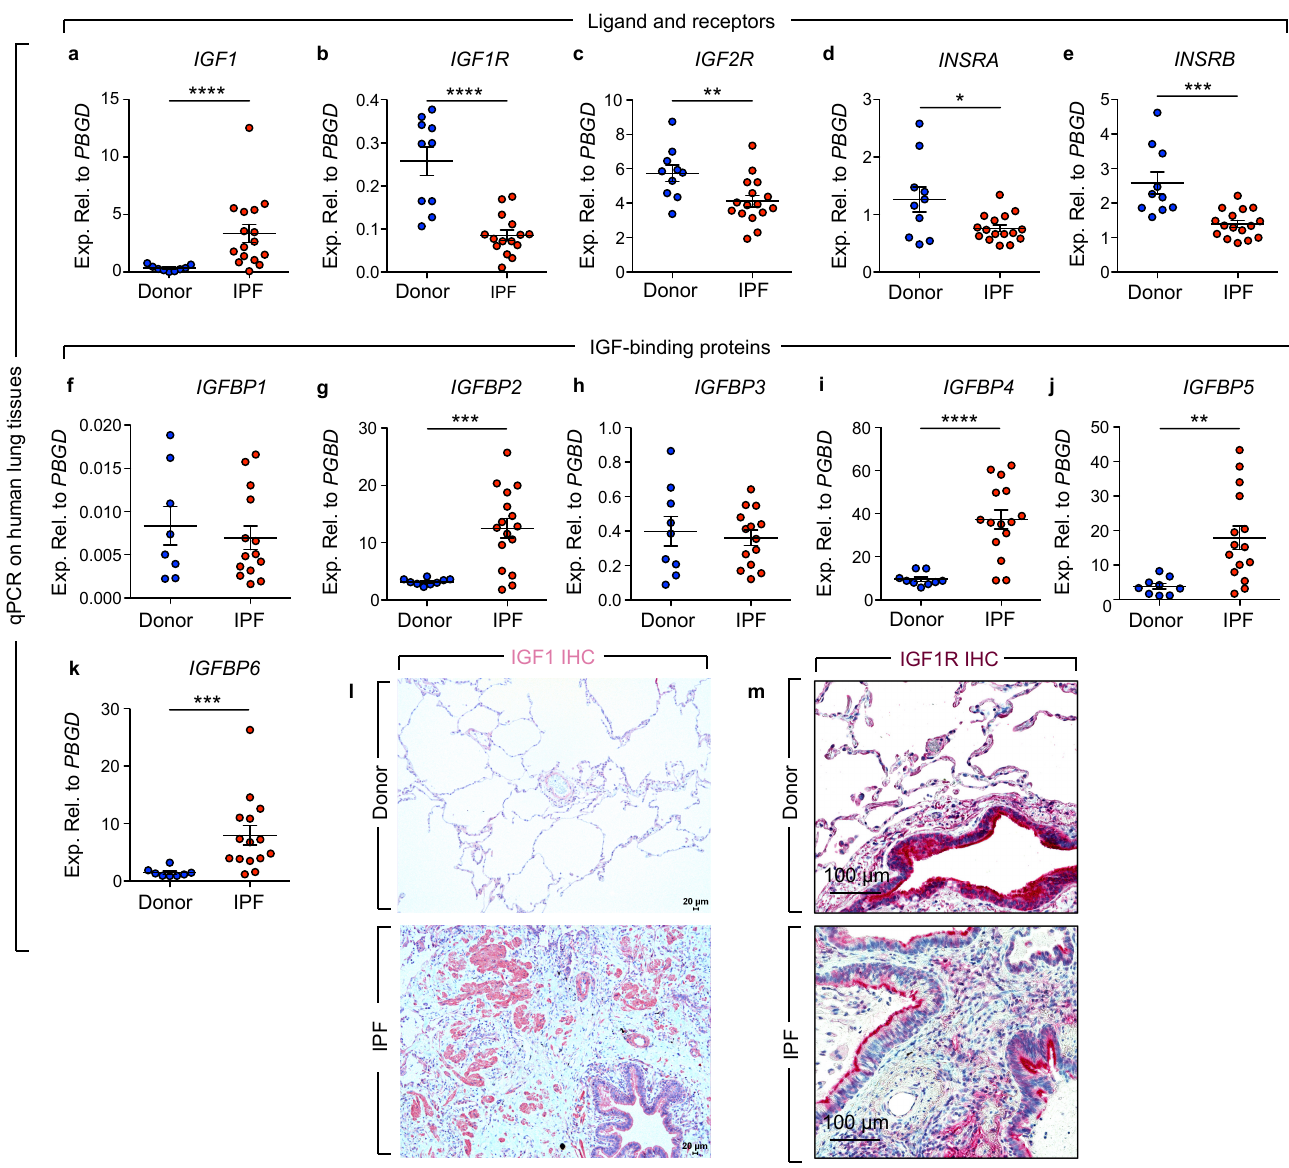
Figure 3. Alteration of IGF1 signaling in idiopathic pulmonary fibrosis. ( a – k ) qPCR on homogenates of lung explants derived from donor or IPF patients; ( l , m ) Immunohistochemistry for IGF1 and IGF1R on donor and IPF lung sections. t -test ( b – e , g – j ) or Mann–Whitney test ( a , f , k ) was performed